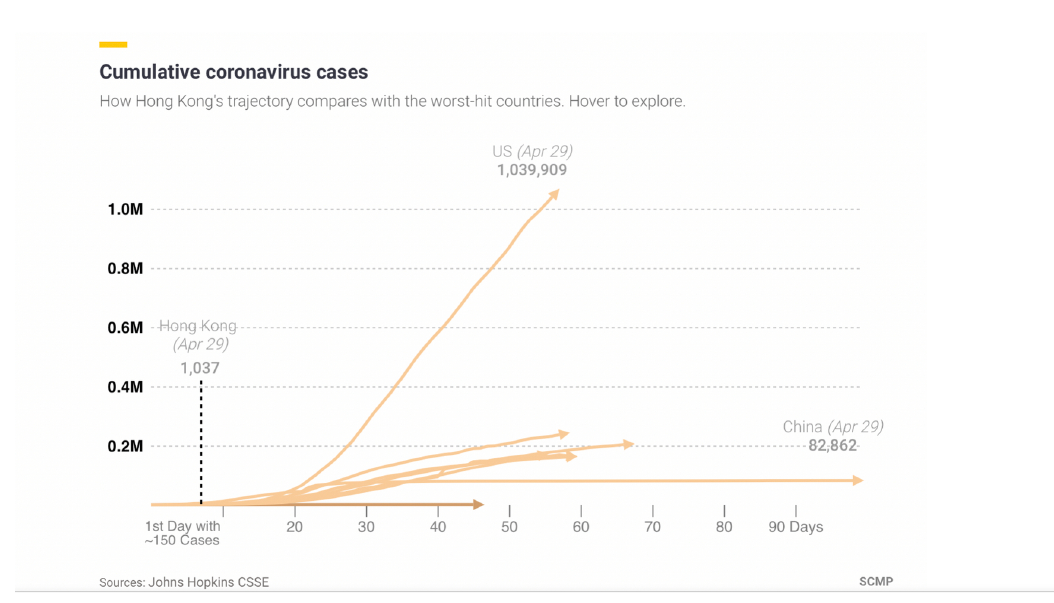
Figure 1. Graph from the South China Morning Post , April 30,